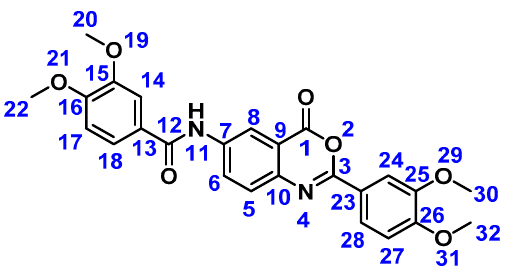
Figure 7. Structure of compound 5 and atom numbering used for NMR characterization